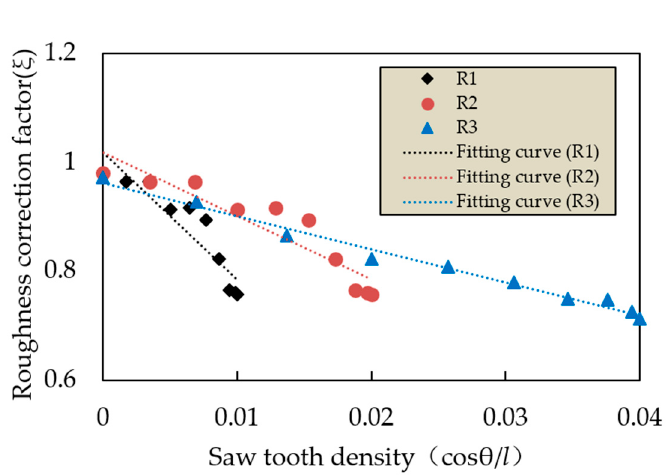
Figure 17. Roughness correction factor under different saw tooth combination conditions.